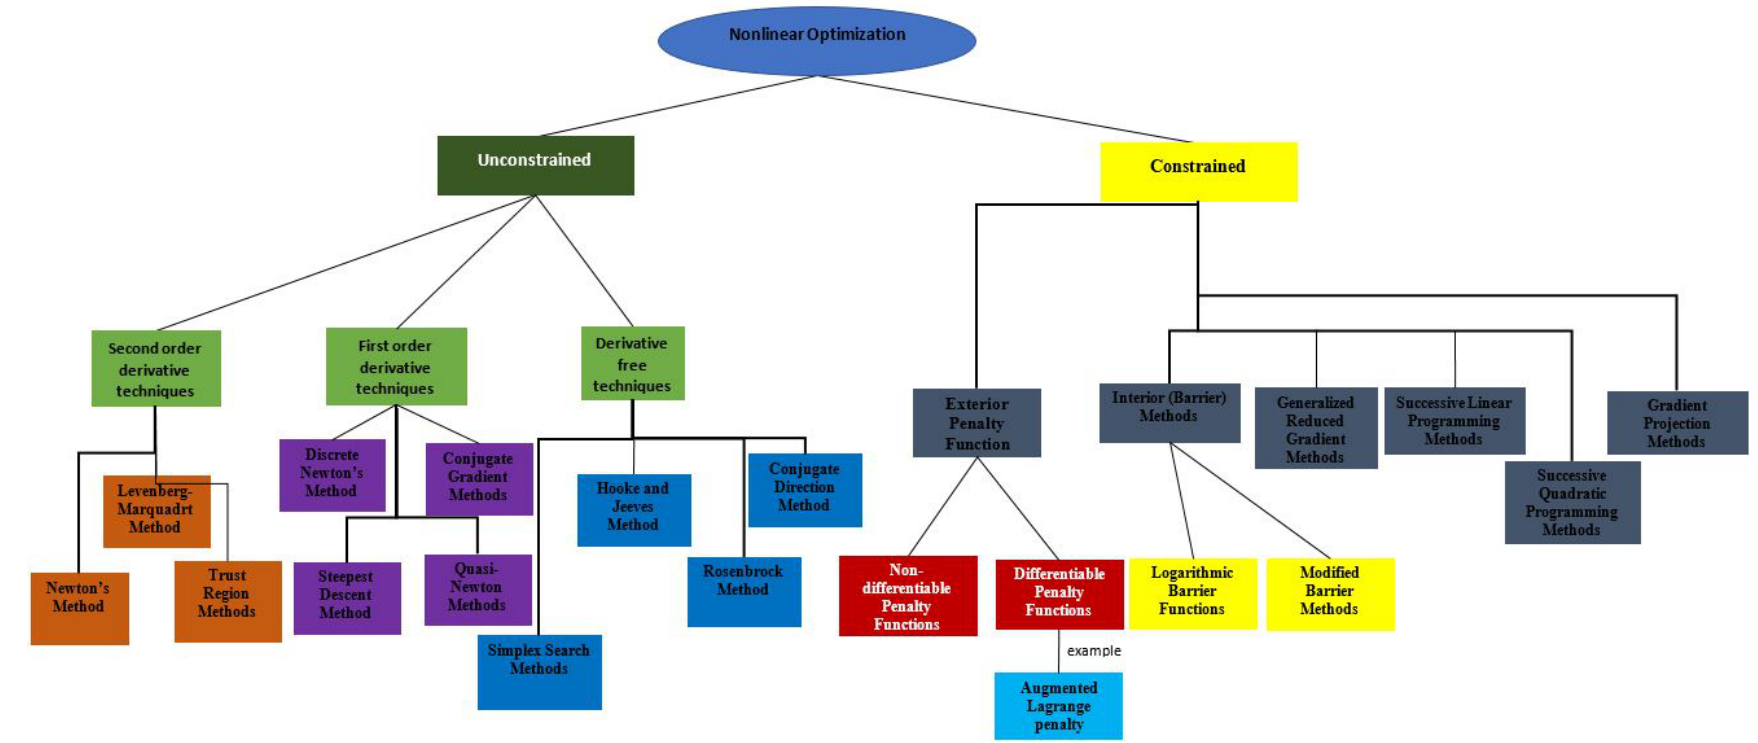
Figure 9. Taxonomy of nonlinear programming (NLP) optimization